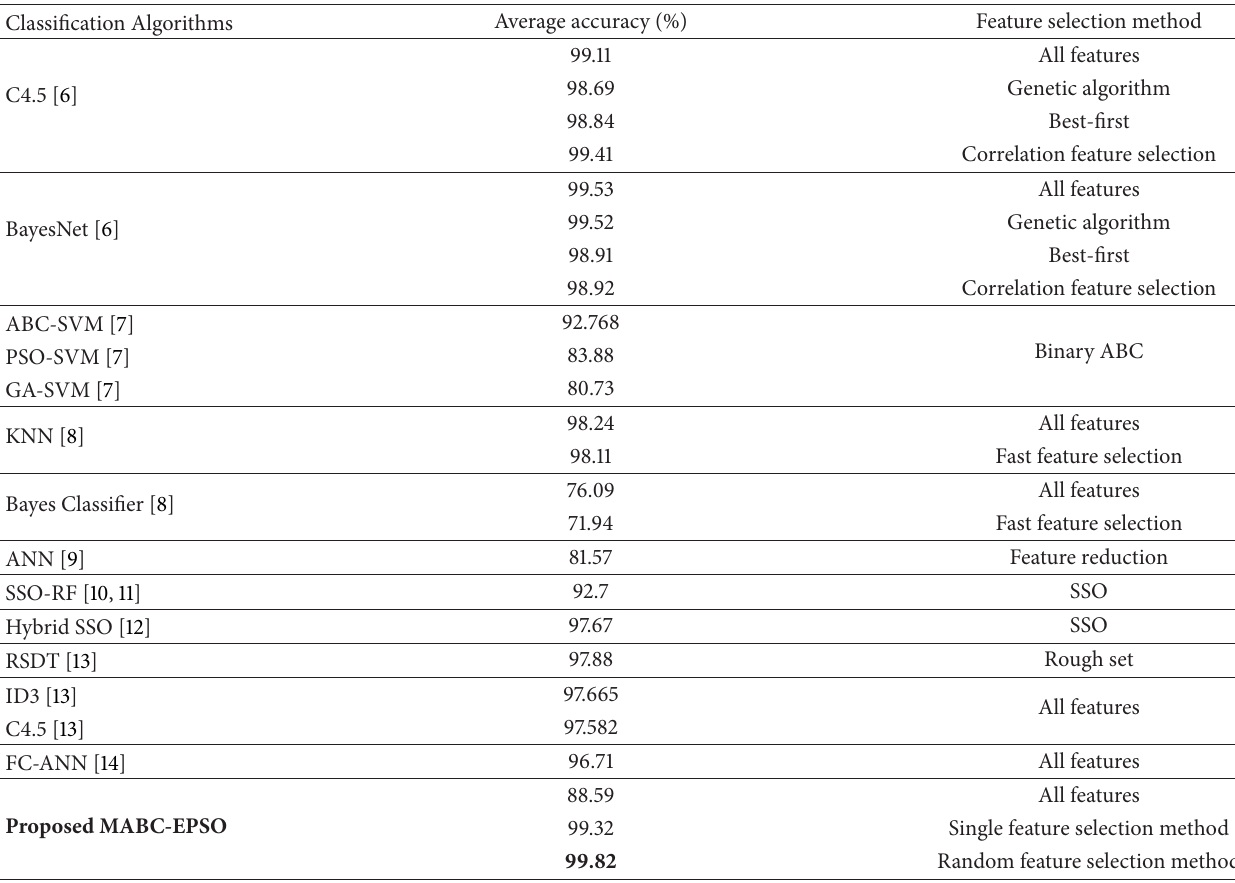
Table 8: Performance comparison of classification algorithms on accuracy rate.